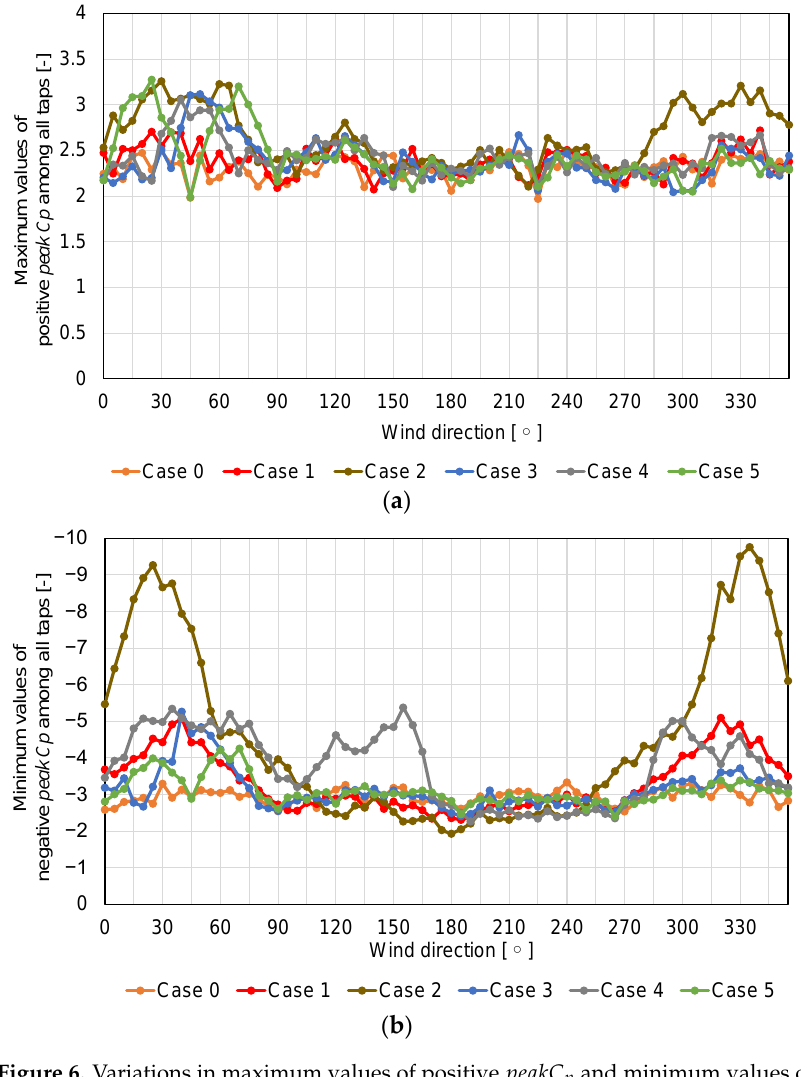
Figure 6. Variations in maximum values of positive 𝑝𝑒𝑎𝑘𝐶 𝑝 and minimum values of negative 𝑝𝑒𝑎𝑘𝐶 𝑝 among all taps for wind directions and locations of a high-rise building; ( a ) positive 𝑝𝑒𝑎𝑘𝐶 𝑝 ; ( b ) negative 𝑝𝑒𝑎𝑘𝐶 𝑝 .